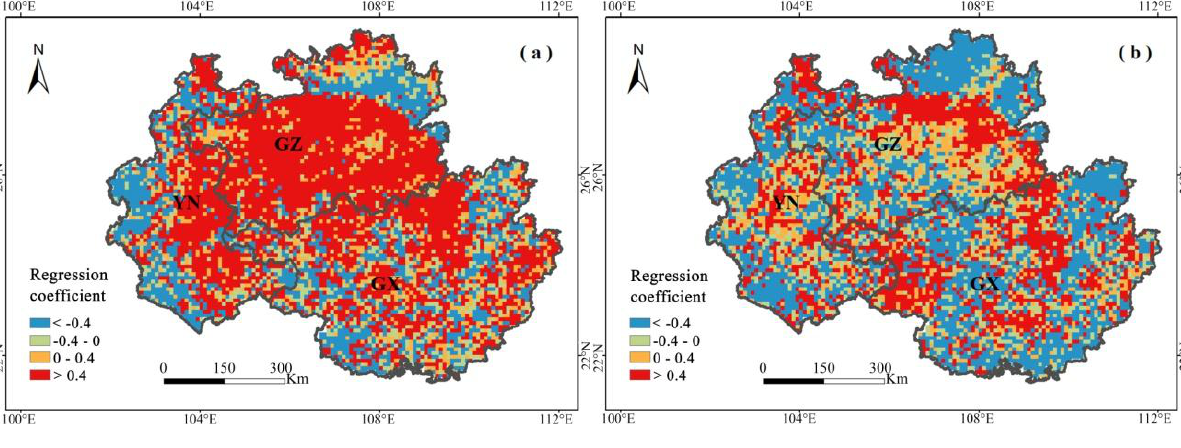
Figure 10. Multivariate regression coefficients of temperature ( a ); and precipitation ( b ) to NDVI based on pixel during